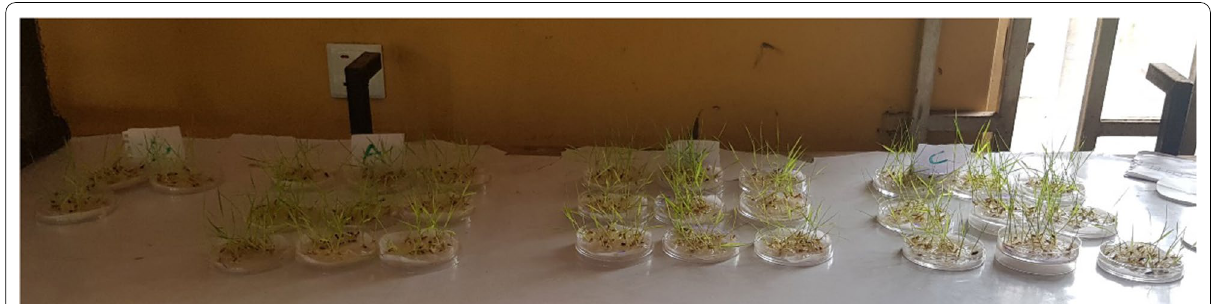
Days after sowing, A =